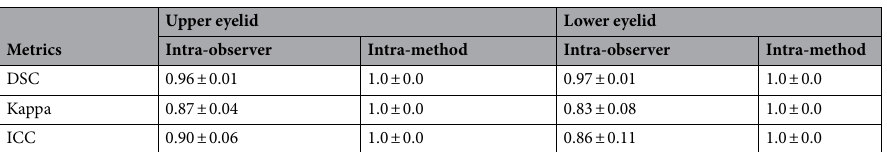
Table 3. Variability and repeatability analysis of intra-observer and intra-method on test dataset images. Intra-observer = between manual annotations of the same observer, Intra-method = between automatic segmentations running two